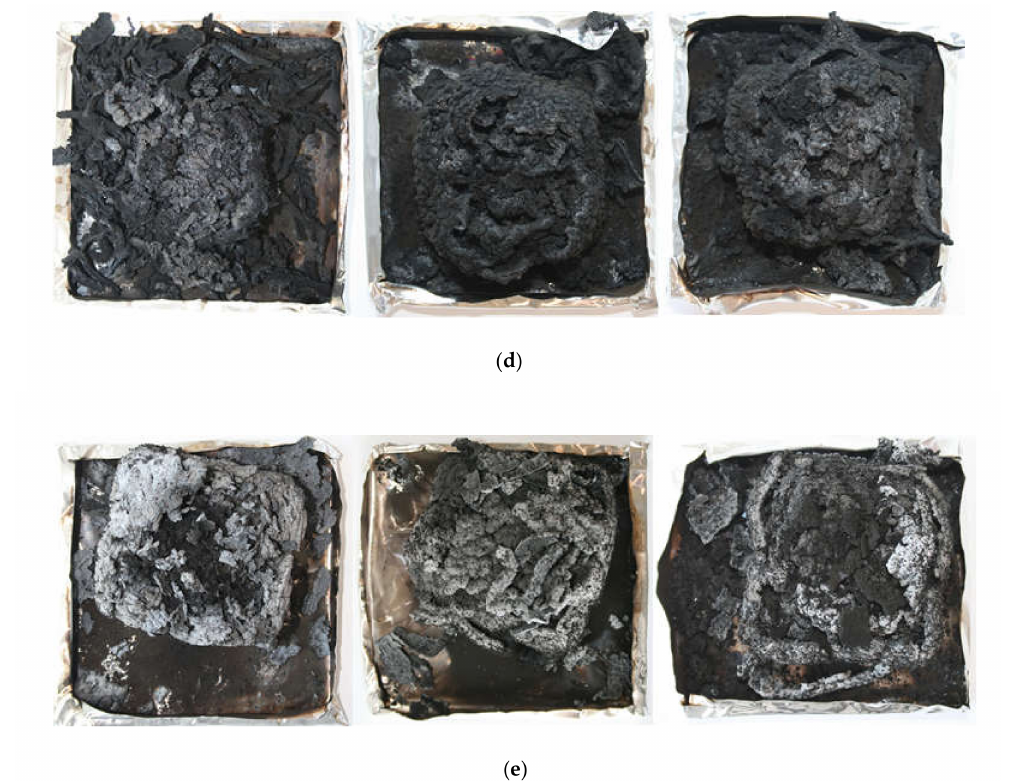
Figure 9. Photographs of the PVC-P ( a ), 10-30 APP ( b ), 10-30 n/H ( c ), 10-30 n/LHP ( d ), and 10-30 n/LHP/ZB ( e ) after cone calorimetry